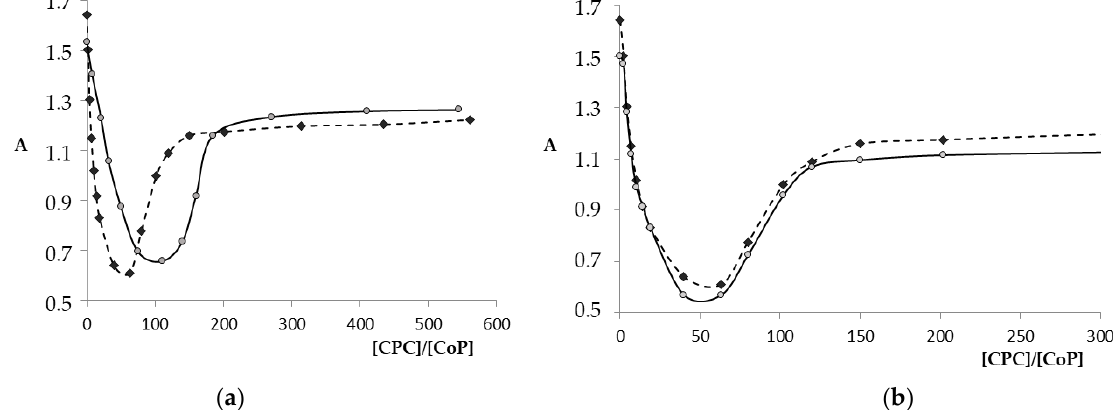
Figure 8. Co(III)P-(L ’ )(L”) titration curves for CPC in phosphate buffer (pH 7.4) at the decreasing (426 nm) and increasing (436 nm) wavelengths: ( а ) Co(III)P1-(L2)(H 2 O) ( ) and Co(III)P1-(L2) 2 ( ) and ( b ) Co(III)P1-(L2)(H 2 O) ( ) and Co(III)P2-(L2)(H 2 O) ( ). Table 3. CPC concentrations at which premicellar aggregates and micellated porphyrinates are formed (С porph. = 1.15 10 −5 M). С CPCAgg, M (N a = С CPC /С porph. )